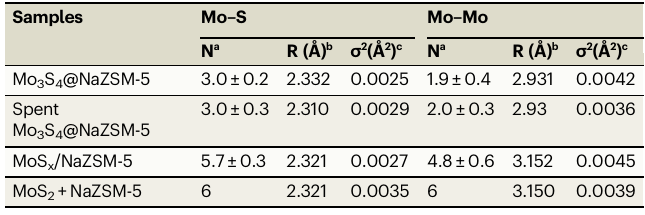
Table 1 | Curve- fi tting results for various samples obtained by Fourier-transformed EXAFS spectra